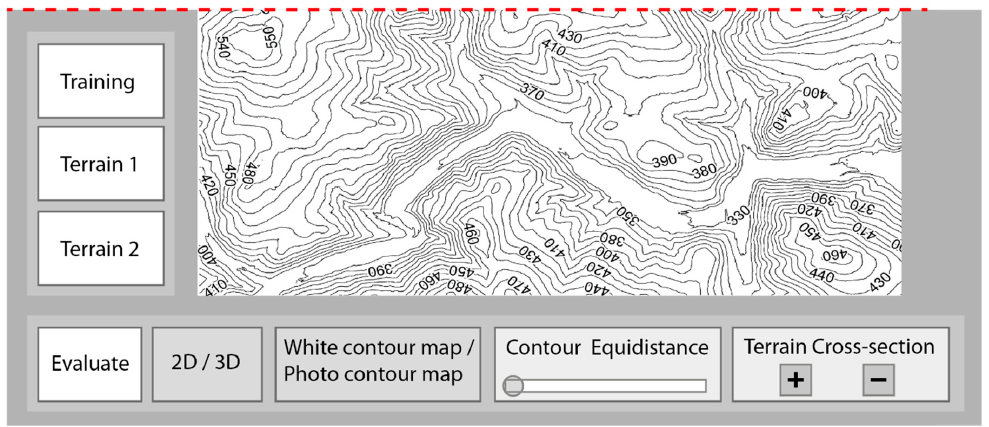
Figure 2. Virtual control panel for model manipulation.